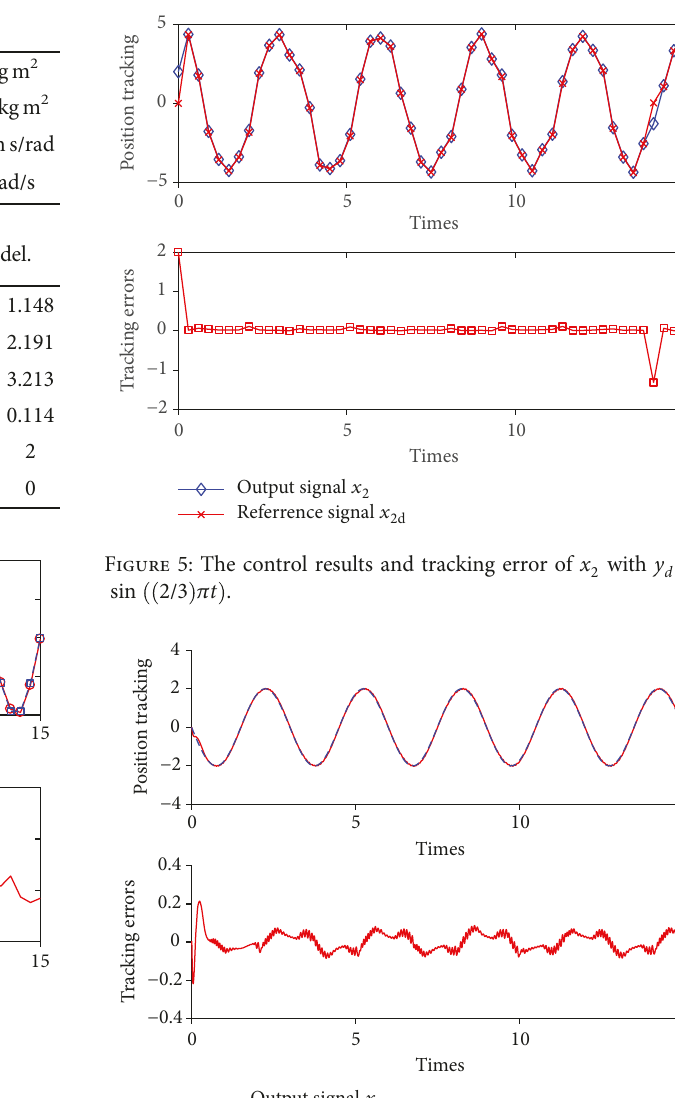
Figure 4: The control results and tracking error of x